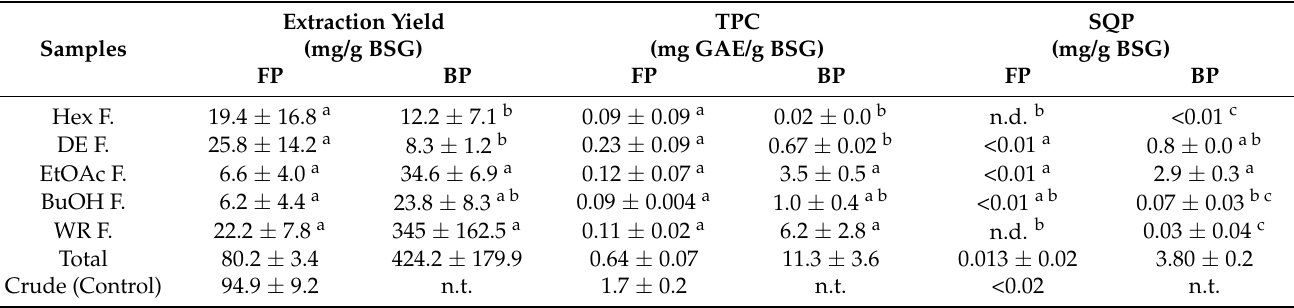
Table 1. Extraction yield (means ± SD) of free phenolics (FP) using 60% acetone and bound phenolic (BP) using 0.75% NaOH expressed in milligram per gram of BSG dry weight (mg/g BSG dw). Extraction Samples